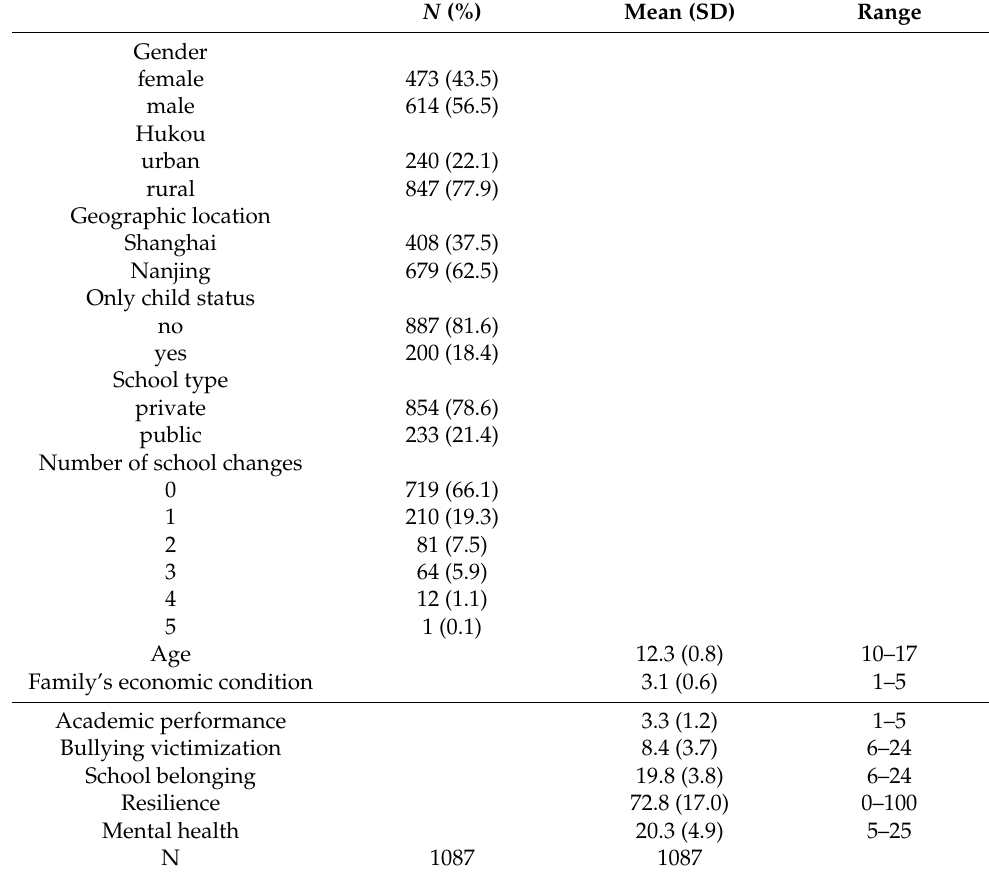
Table 1. Descriptive statistics of selected variables in the